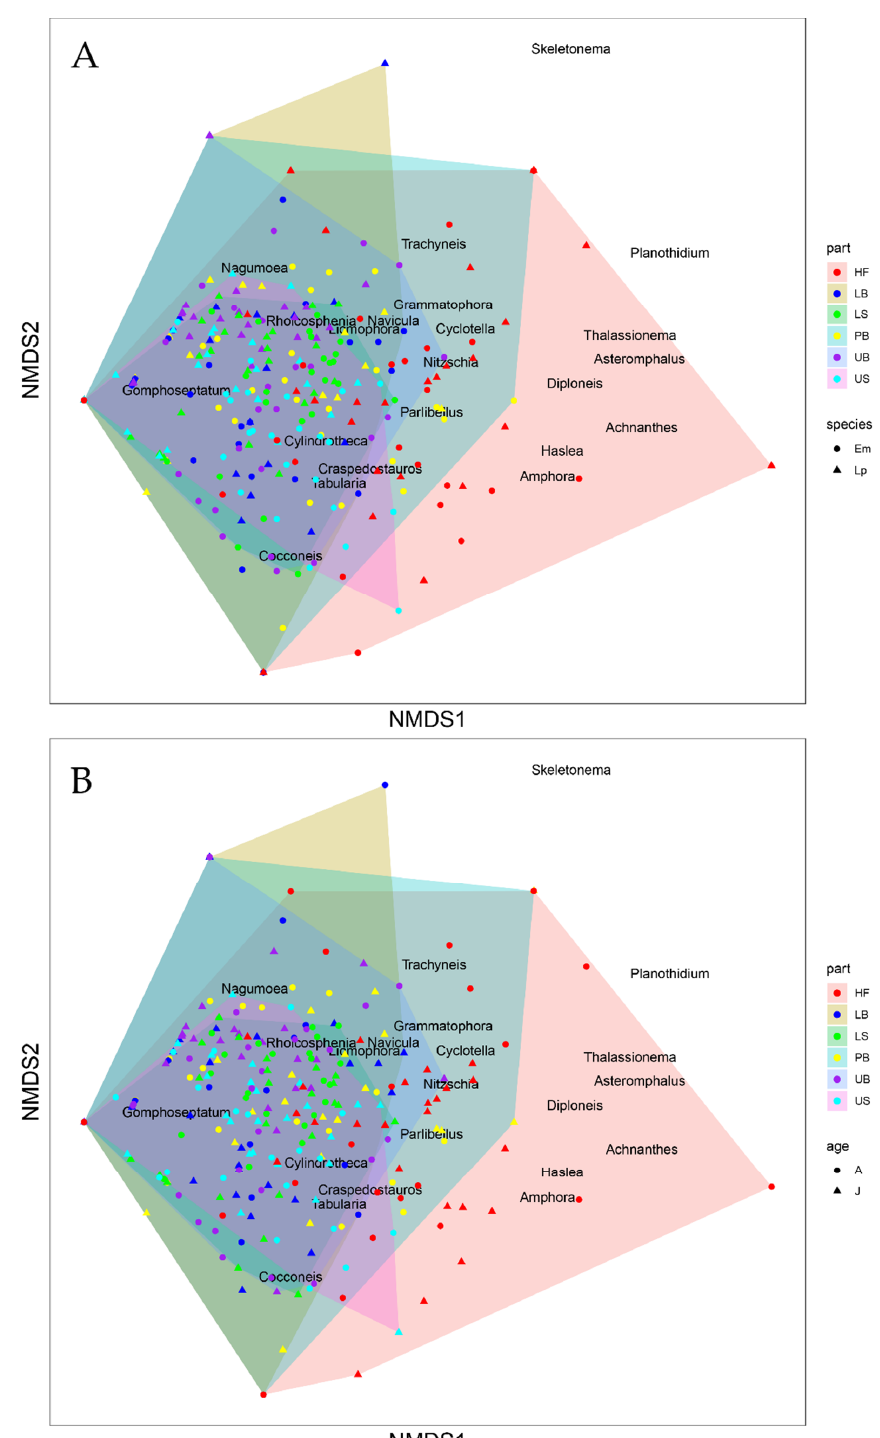
Figure 10. Non-metric multidimensional scaling (nMDS) graphs showing distances between the diatom samples collected from ( A ) different host species and thallus parts and ( B ) different thallus parts of juvenile and adult kelps as their overall dissimilarity (two-dimensional (2D) Stress = ~0.20). HF = Holdfast, LB = Lower blade, LS = Lower stipe, PB = Primary blade, UB = Upper blade, US = Upper stipe; Em = Ecklonia maxima , Lp = Laminaria pallida ; A = Adult, J = Juvenile.